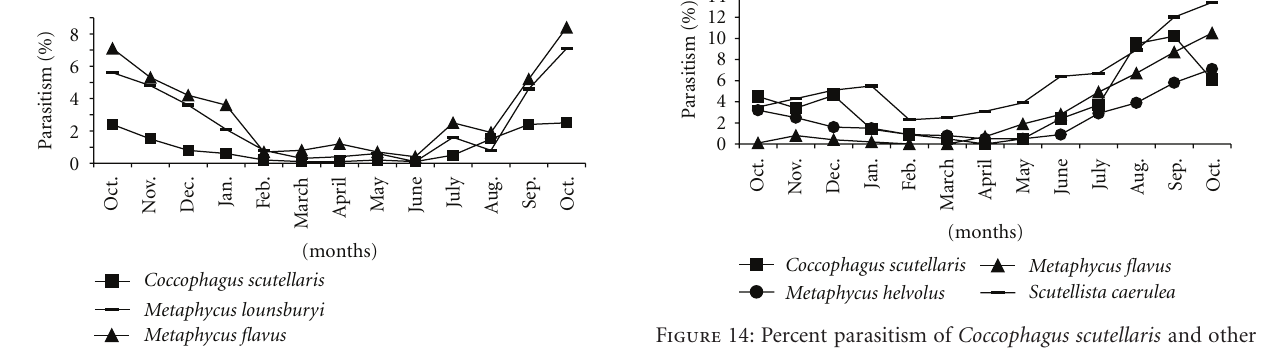
Figure 12: Percent parasitism of Coccophagus scutellaris and other associated parasitoids of Saissetia co ff eae on olive in Marsa Matruh governorate before releasing during 2009-2010.